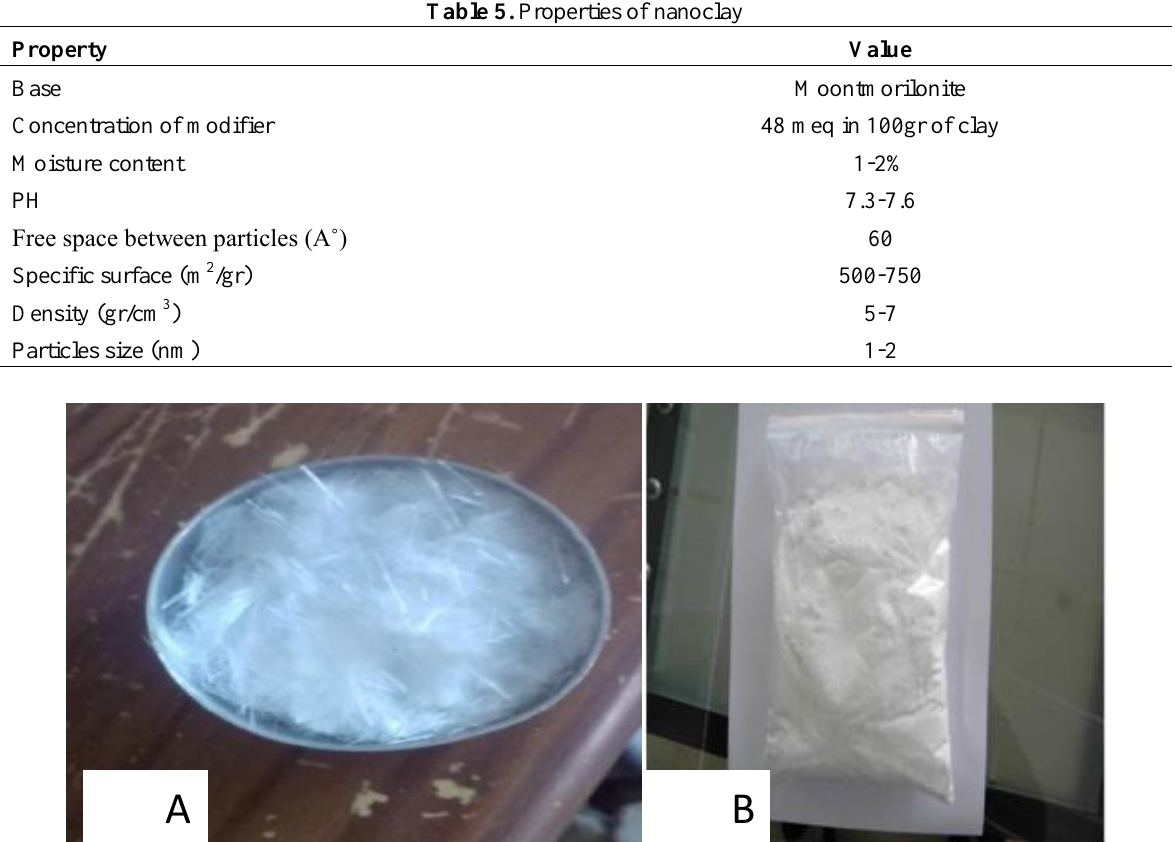
Table 5. Properties of